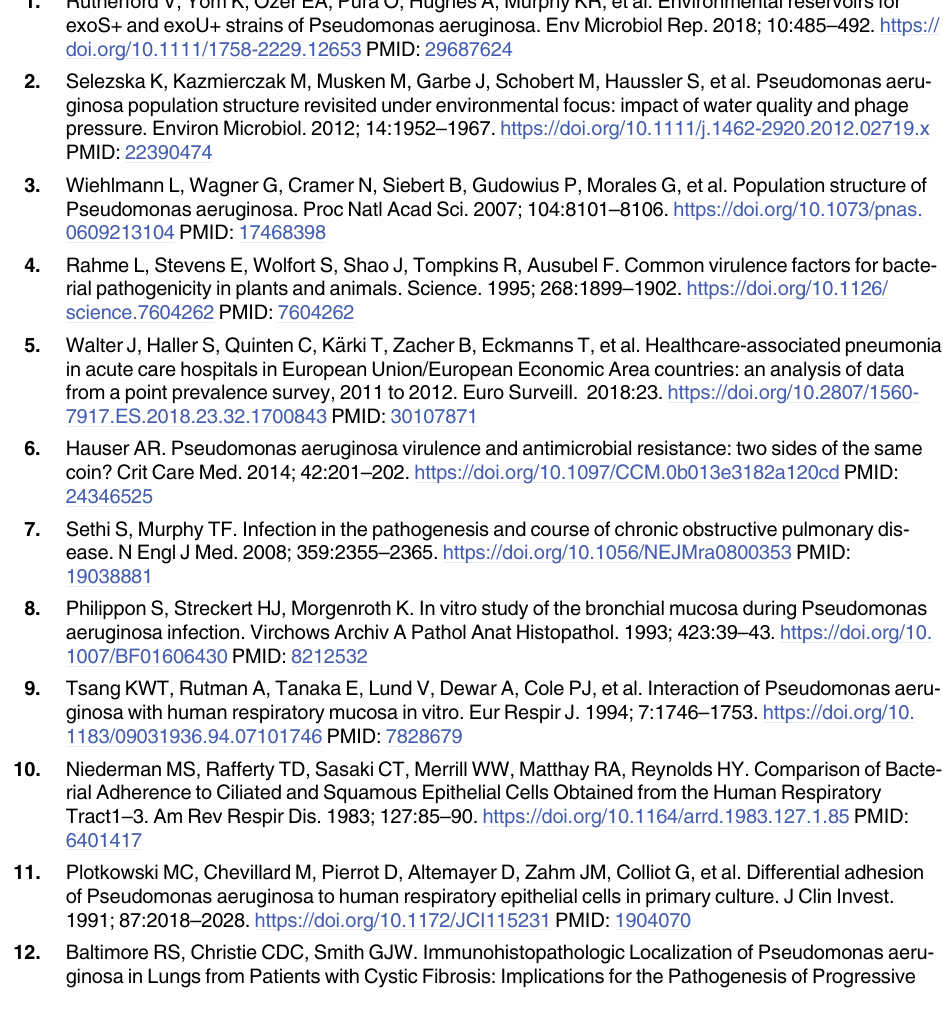
S1 Table. Models of airway epithelia cells used in the references of the review. ECM, extra- cellular matrix; ND/NR, not determined/not